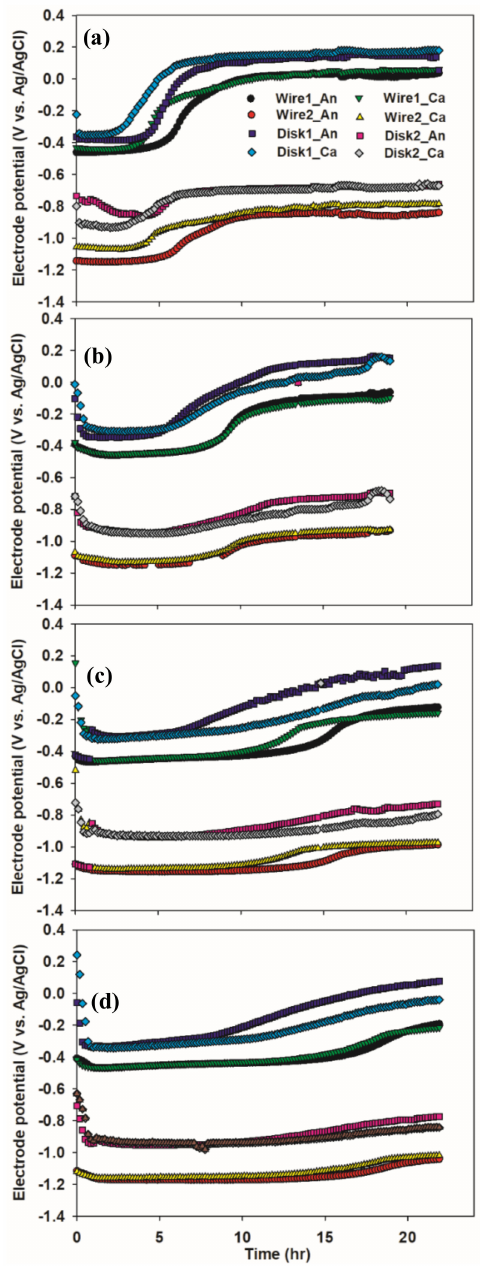
Figure 3. Anode and cathode potentials versus Ag/AgCl reference electrodes at different substrate concentrations: ( a ) 0.4 g/L, ( b ) 0.6 g/L, ( c ) 0.8 g/L, and ( d ) 1.0